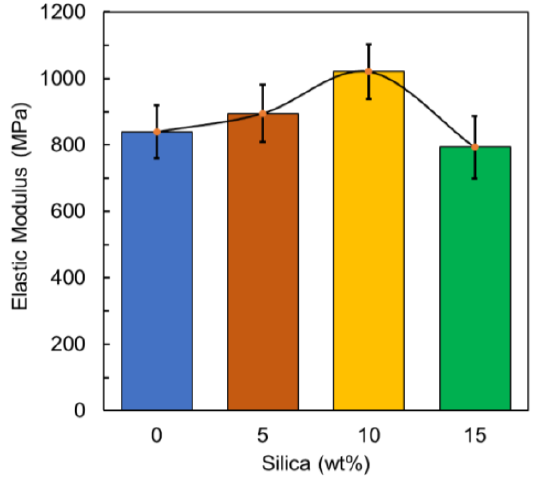
Figure 14. Elastic modulus blends.